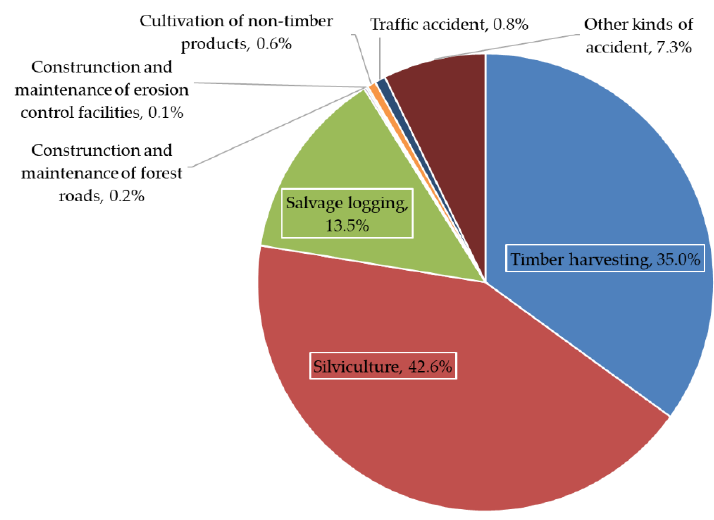
Figure 4. Distribution of occupational accident rates by operation type.